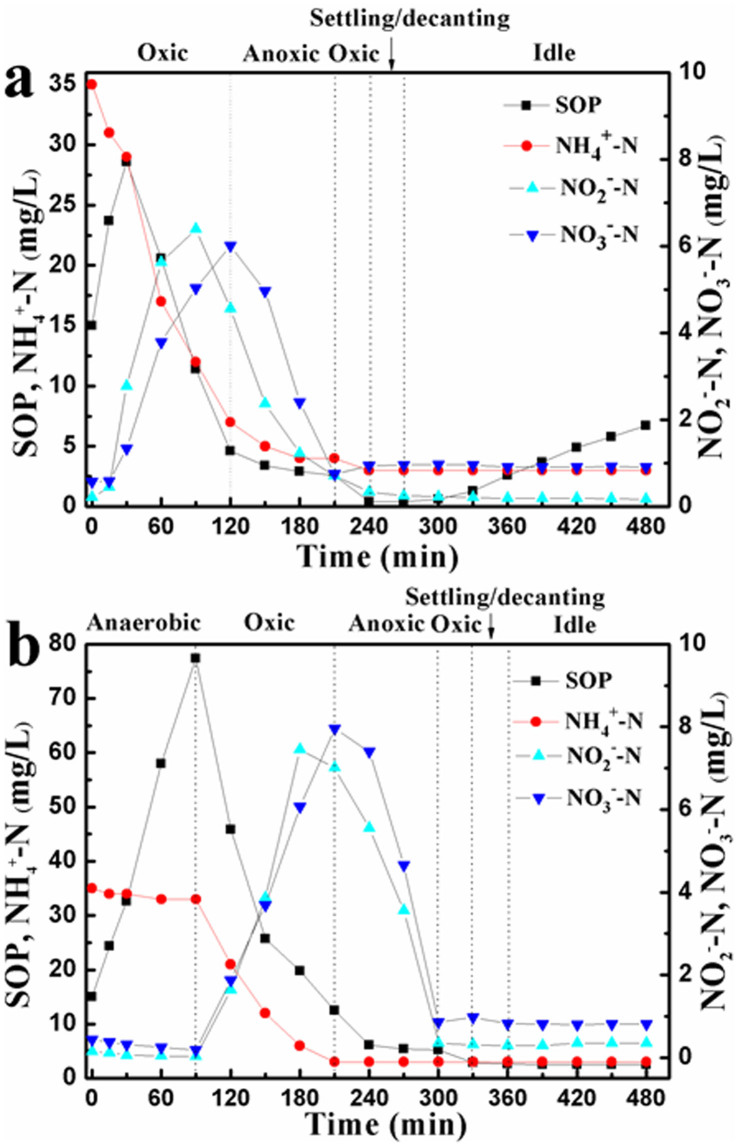
Changes of SOP, NH4+-N, NO2--N, and NO3--N in one typical cycle of O/A/O/EI (a) and A/O/A/O (b) reactors (on day 80).